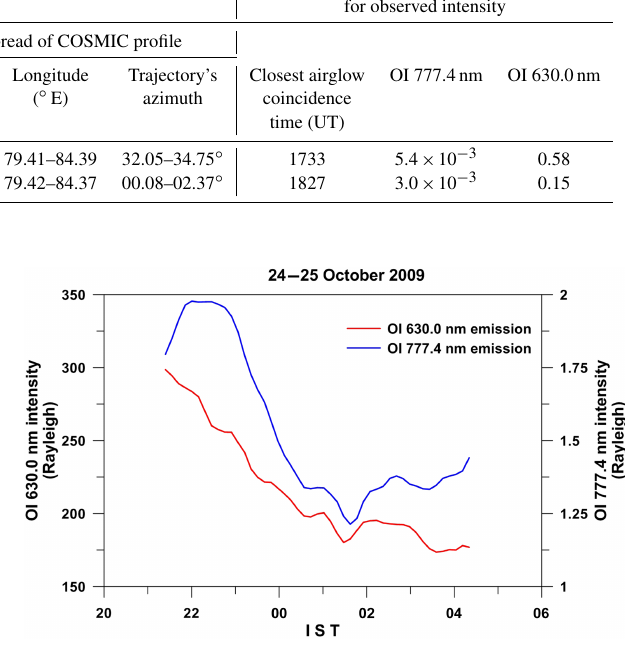
Figure 2. Nocturnal variation of the calibrated intensity of OI 777.4 and 630.0nm emissions on 24 October 2009